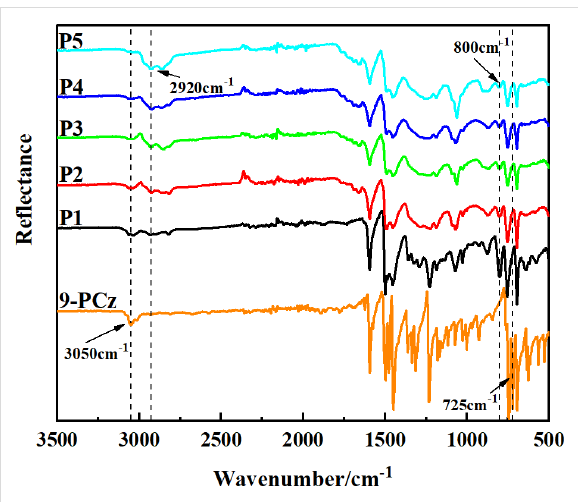
Figure 1: FTIR spectrum of HCPs P1 – P5 and 9-PCz.